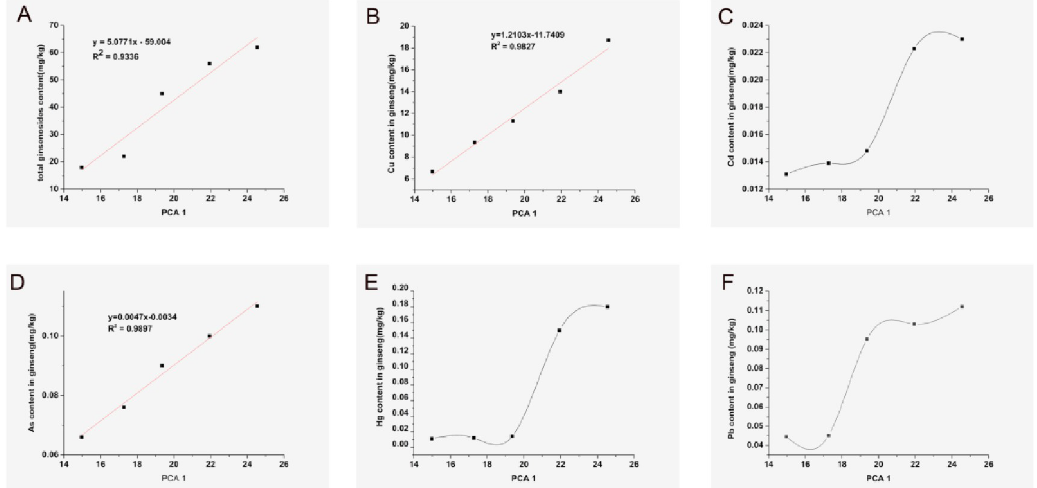
Fig 5. Effect of PCA1 on ginsenoside content and heavy metal content in ginseng. A: The relationship of total ginsenosides content with PCA1. B: The relationship of Cu content in ginseng with PCA1. C: The relationship of Cd content in ginseng with PCA1.D: The relationship of As content in ginseng with PCA1.E: The relationship of Hg content in ginseng with PCA1.F: The relationship of Pb content in ginseng with PCA1.